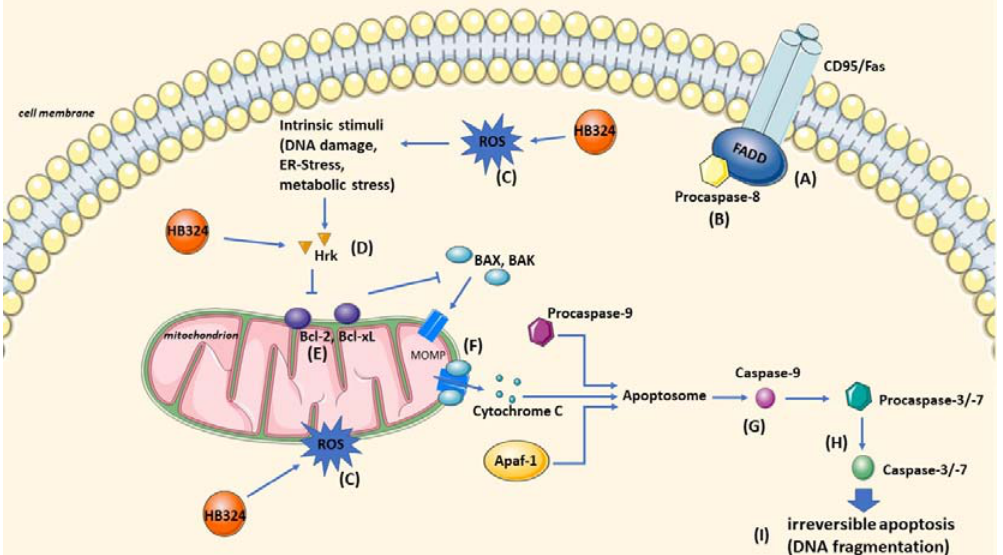
Figure 8. Illustration of the cellular targets and effects of HB324. Marked are the cellular targets identified by different detection methods in this paper. ( A ) FADD by cell pair model BJAB and BJAB FADD − / − . ( B ) Caspase-8 by Western blot and cell pair model SK-N-AS and LiOn. ( C ) ROS by apoptosis detection with and without the ROS inhibitor NAC. ( D ) Harakiri by Western blot and cell pair model K562 and NiWi-Dau. ( E ) Bcl-2 by cell pair model BJAB and BiBo. ( F ) Mitochondrial outer membrane permeabilization by JC-1. ( G ) Caspase-9 by Western blot. ( H ) Caspase-3 by Western blot and cell pair model BJAB and 7CCA. ( I ) Apoptosis by DNA fragmentation measurement.